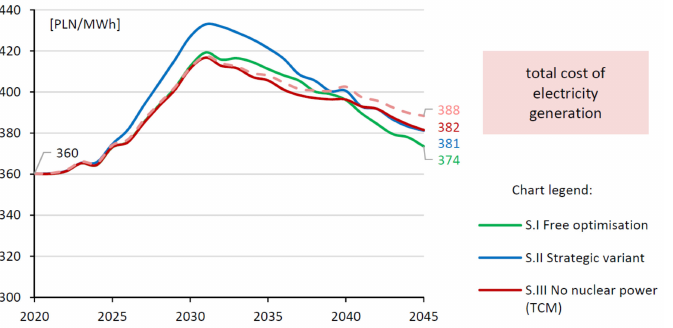
Figure 5. Nuclear power in the longer term reduces the average total cost of electricity generation compared to variants without NPP (free optimisation scenario–7,7 GWe nuclear power plants until 2045, strategic variant–6,6 GWe nuclear power plants until